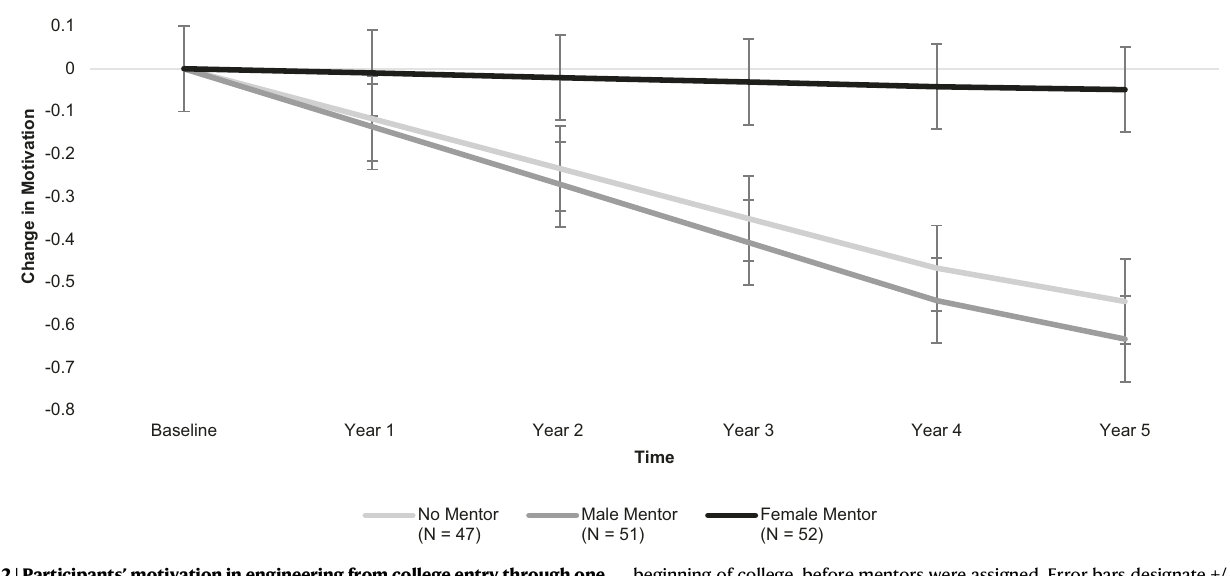
Fig.2|Participants ’ motivationinengineeringfromcollegeentrythroughone year post-graduation. Depicts differences between intervention conditions (no mentor,malementor,femalementor)inparticipants ’ averagechangeinmotivation intheirengineeringcoursesover fi veyears,relativetotheirmotivationlevelsatthe